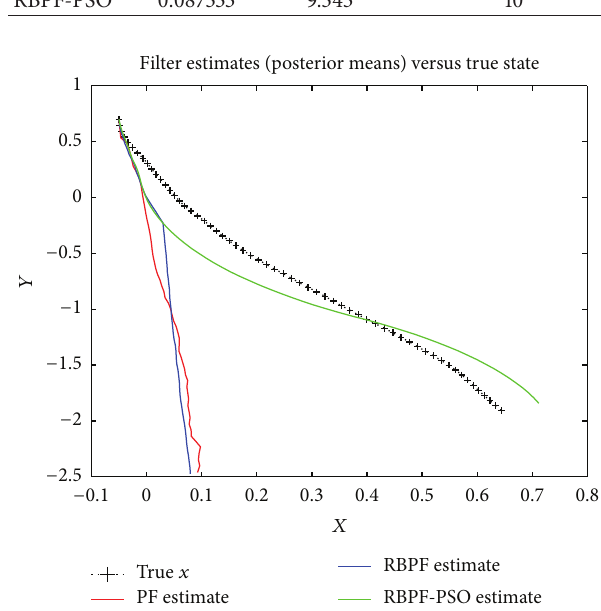
Figure 1: The estimations of different particle filters when the regular PF diverges.